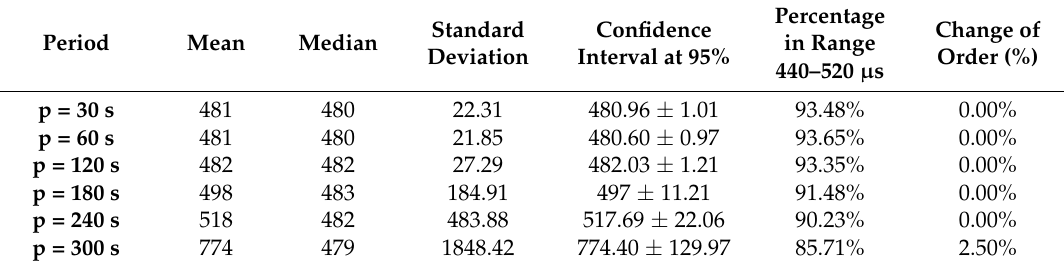
Table 5. Results obtained in the sequence experiment with